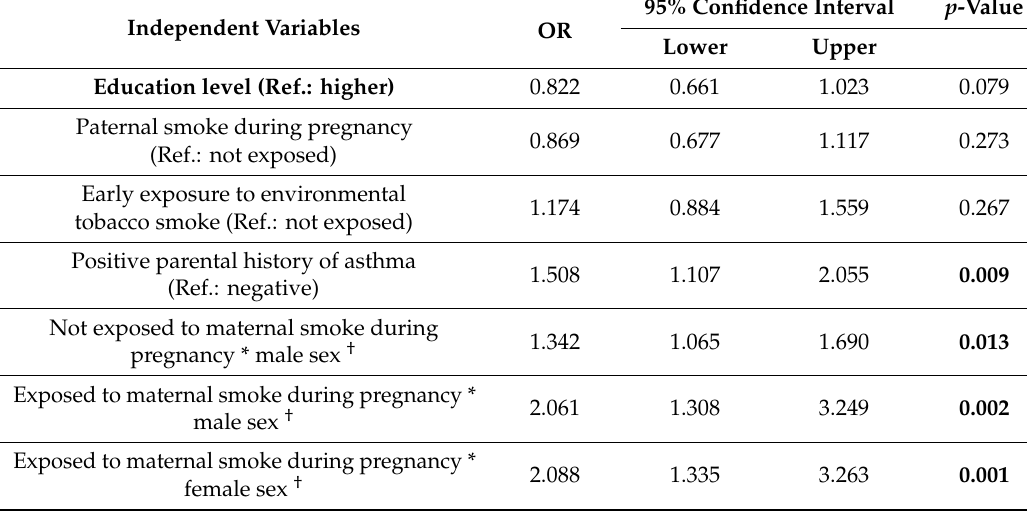
Table 3. Multiple logistic association model for acute respiratory diseases in the first two years in the overall study population. In this table, four combinations of exposure to maternal smoke during pregnancy and sex were separately evaluated. OR: Odds Ratio. Significant p values are in bold.